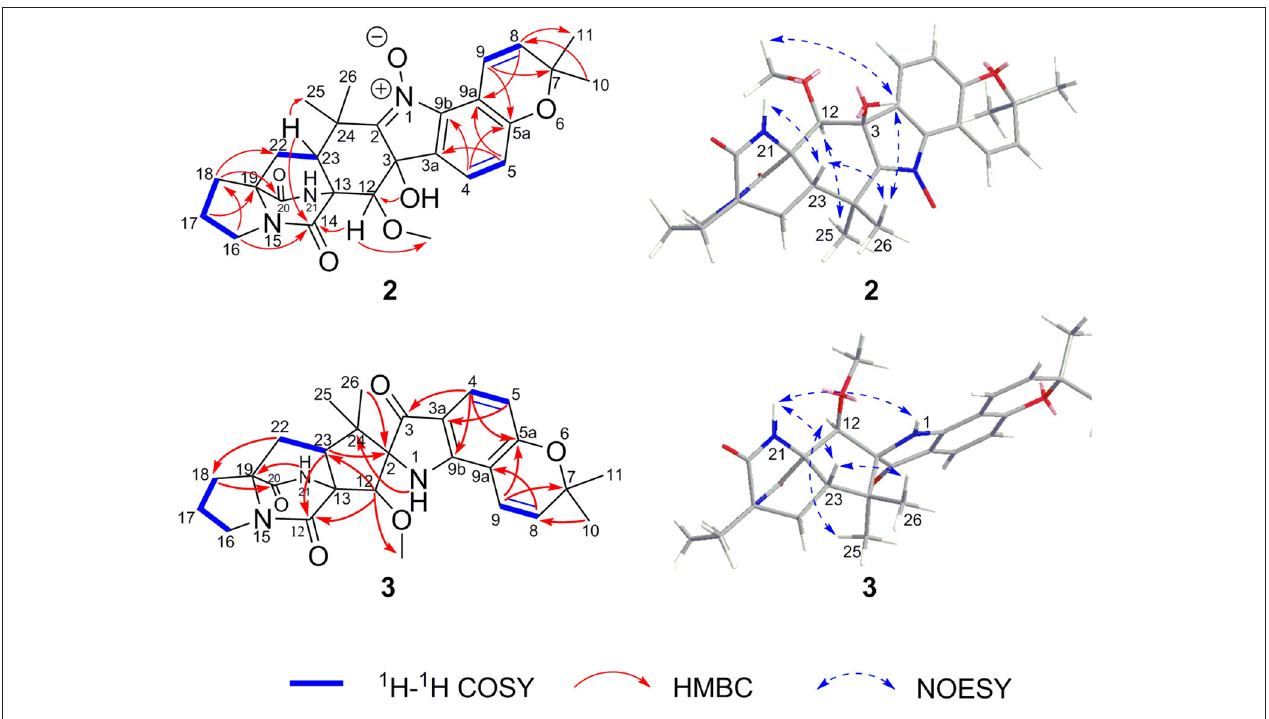
FIGURE 5 | Key 2D NMR correlations for 2 and 3 .